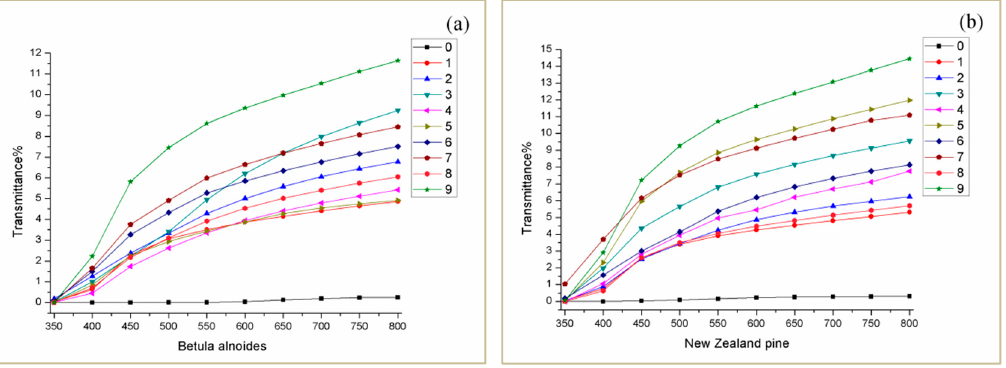
Figure 5. The light transmittance of OW and TW for two tree species ( a ), ( b ).